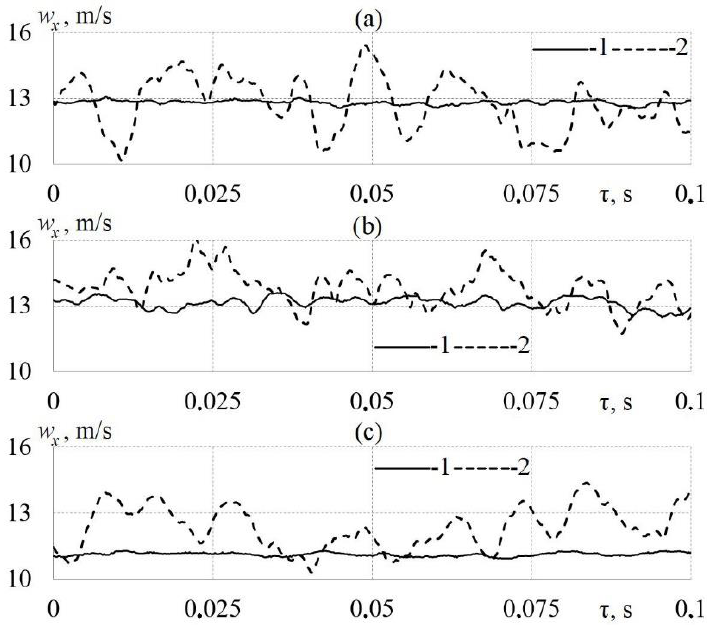
Figure 4. Dependences of the instantaneous values of the local ( l x = 100 mm) velocity w x in time at the intensity of the flow turbulence TI = 0.02 (1) and TI = 0.12 (2) in pipes with different cross-sections: ( a ) round (average velocity w ≈ 13 m/s); ( b ) square ( w ≈ 13 m/s); ( c ) triangle ( w ≈ 12 m/s).